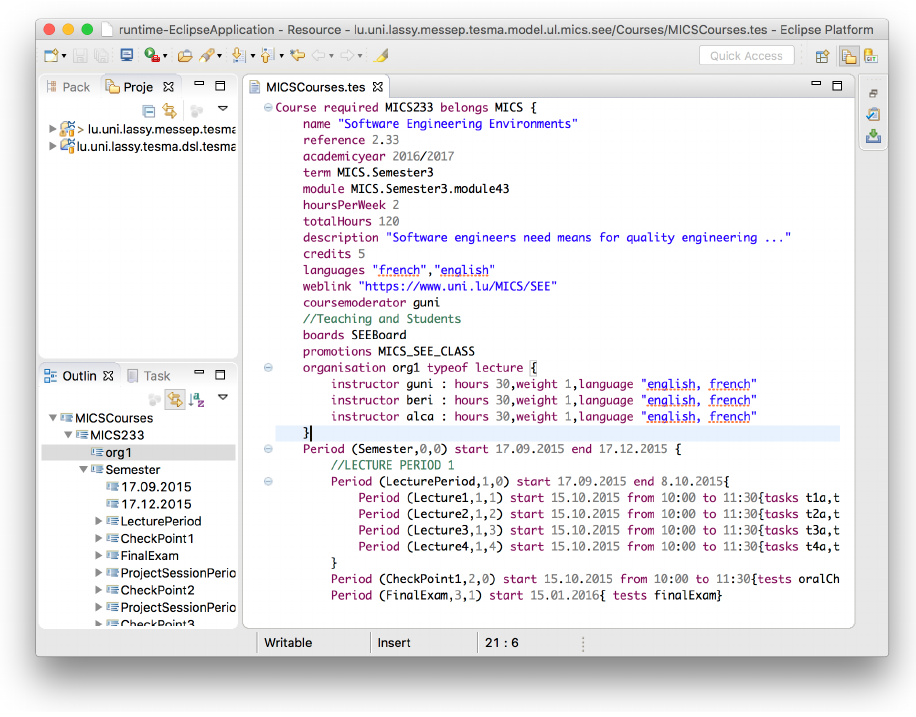
Figure 6. An example of course specification in the TESMA textual